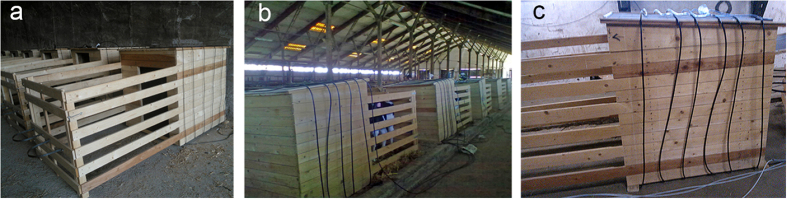
Individual wooden boxes for calves with coils producing ELFMF.